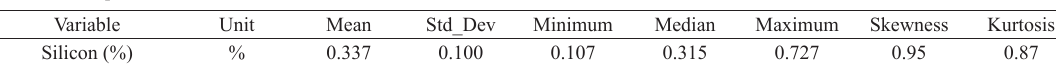
Table 13. Output